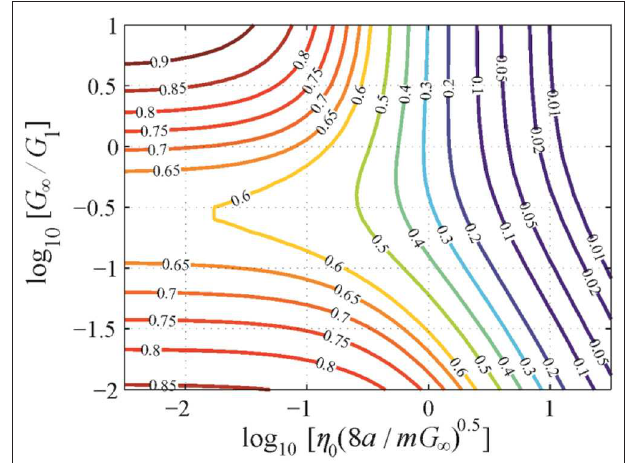
FIGURE 3 | Contour line diagram of the coefficient of restitution as a function of the governing nondimensional parameters for the impact of a cylindrical flat punch onto a Kelvin–Maxwell